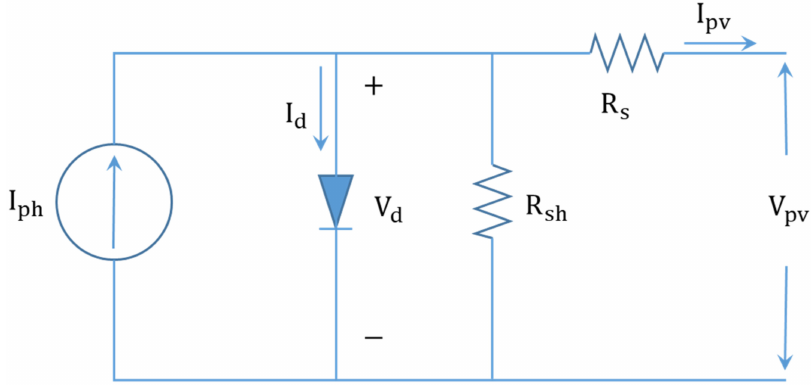
Figure 1. Equivalent of solar